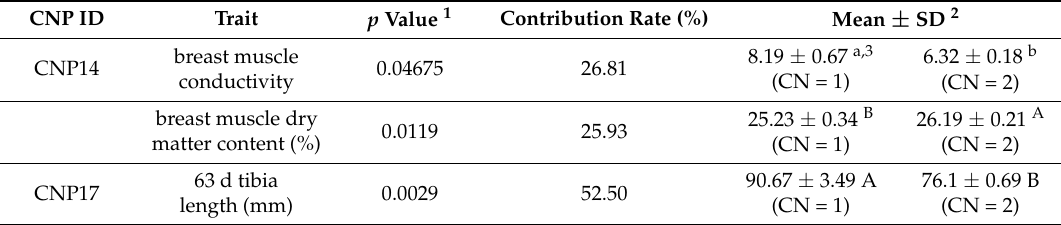
Table 3. Association of CNPs in the XH × WRR full sib F2 resource group and economic traits.